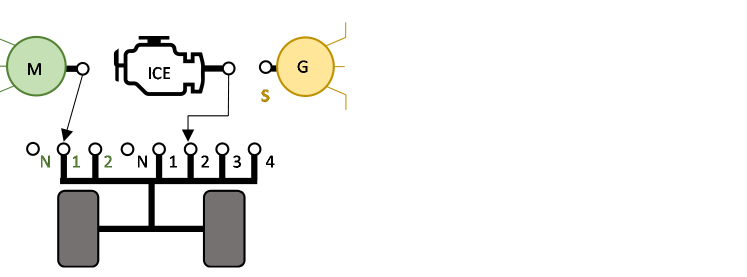
Figure 7. Powertrain architecture of the vehicle, including the parallel and series